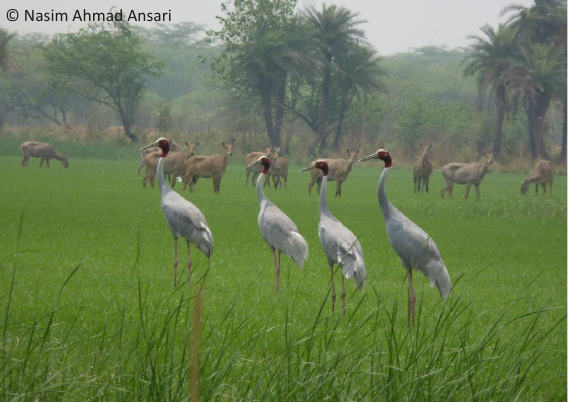
Image 2. Overview of Surajpur Wetland - monsoon season